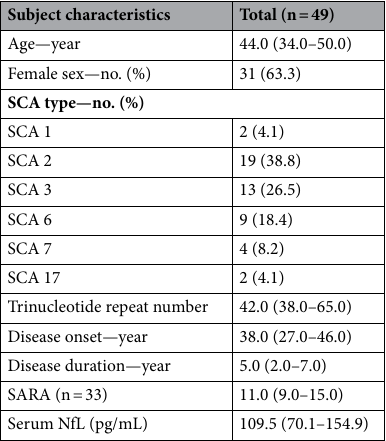
Table 1. Clinical characteristics of autosomal-dominant spinocerebellar ataxia patients and serum neurofilament light chain levels. Data are reported as the number (percentage), or as the median (interquartile range, IQR). SCA spinocerebellar ataxia, SARA scale for the assessment and rating of ataxia, NfL neurofilament light